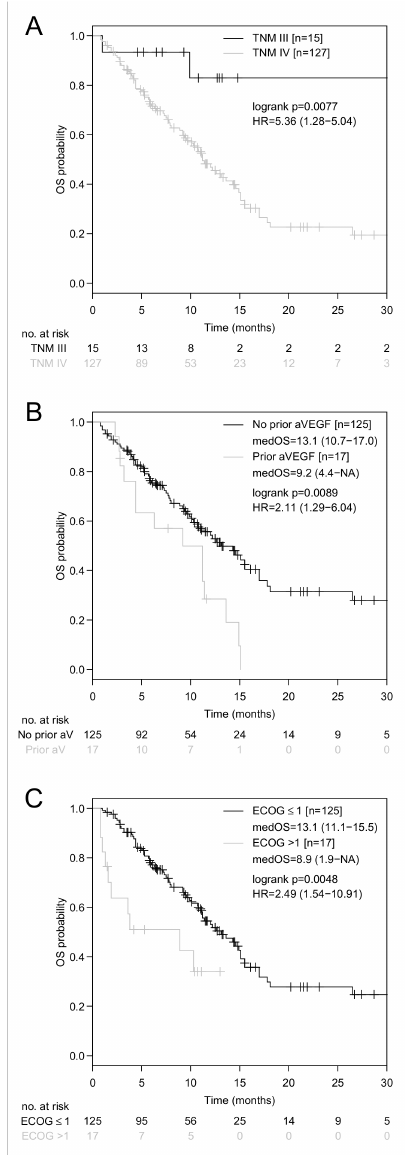
Figure 2. Kaplan-Meier curves for OS according to the TNM stage, prior or concomitant anti-VEGF targeting therapy and ECOG performance status. Comparison of Kaplan-Meier curves for OS in advanced NSCLC patients with TNM stage IV versus III ( A ), administration of prior or concomitant anti-VEGF targeting therapy (yes versus no) ( B ), and ECOG performance status > 1 versus ≤ 1 ( C ). HR is the hazard ratio with a 95% confidence interval in